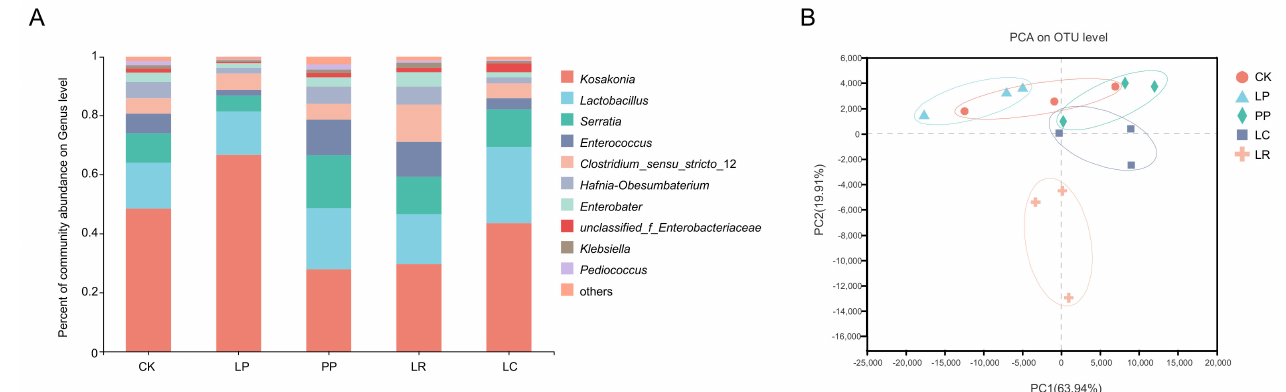
Figure 1. The relative abundance of microbial community at the genus level ( A ) and principal component analysis (PCA) based on operational taxonomic units (OTU) level of the oat silage after 60 days of ensiling ( B ). LP, L. plantarum F1; LR, L. rhamnosus XJJ01; LC, L. paracasei XJJ02; L. paracasei ; PP, P. acidipropionici 1.1161.